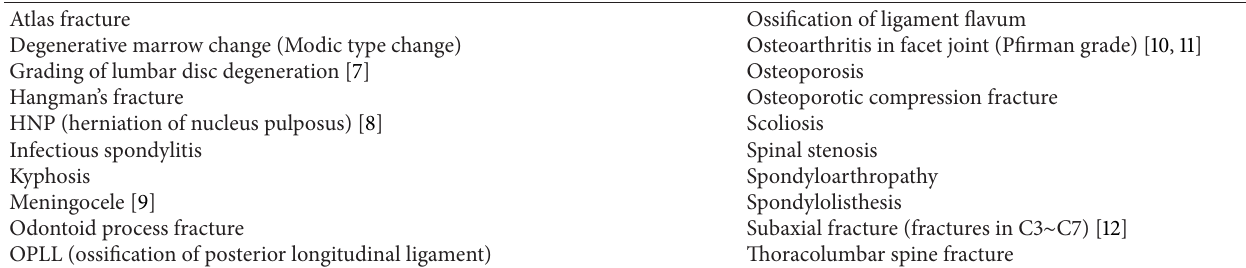
Table 3: The twenty selected